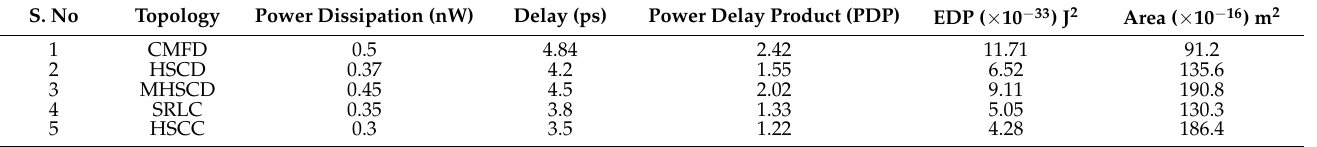
Table 2. Comparison of parameters for various domino logic circuits of temperature value 10 °C.